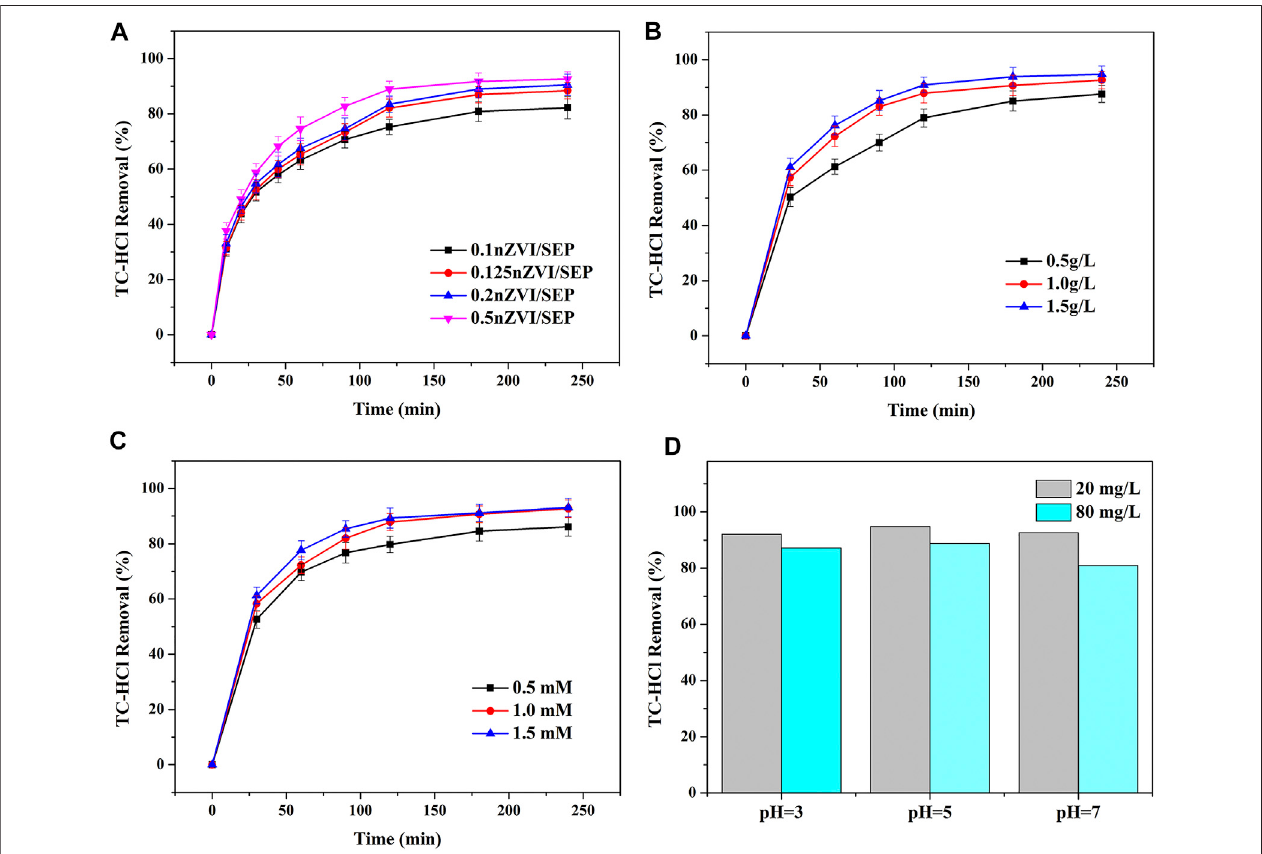
FIGURE 8 | Effect of (A) loading amount of nZVI, (B) catalyst dosage, (C) H 2 O 2 concentration, (D) pH value on TC-HCl removal by 0.5 nZVI/SEP. (Experimental conditions: TC-HCl concentration (cid:1) 20 mg/L, catalyst dosage (cid:1) 0.1 g/L, H 2 O 2 concentration (cid:1) 1 mM, pH (cid:1) 7, room temperature).